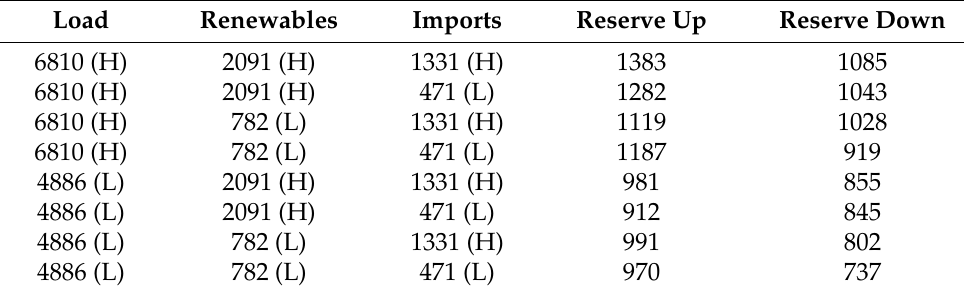
Table 2. Reserve requirement for each type of day. All quantities are in